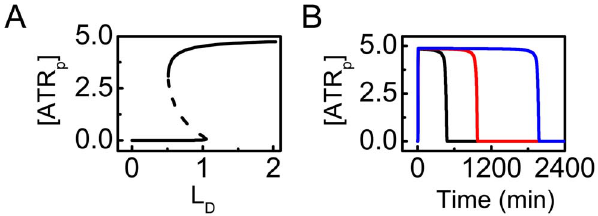
Figure 3. Switching behavior of ATR as a sensor of DNA damage. (A) Bifurcation diagram of [ATR p ] vs. L D (without DNA repair). (B) Time courses of [ATR p ] at L D0 ~ 5 (black), 10 (red), or 20 (blue).